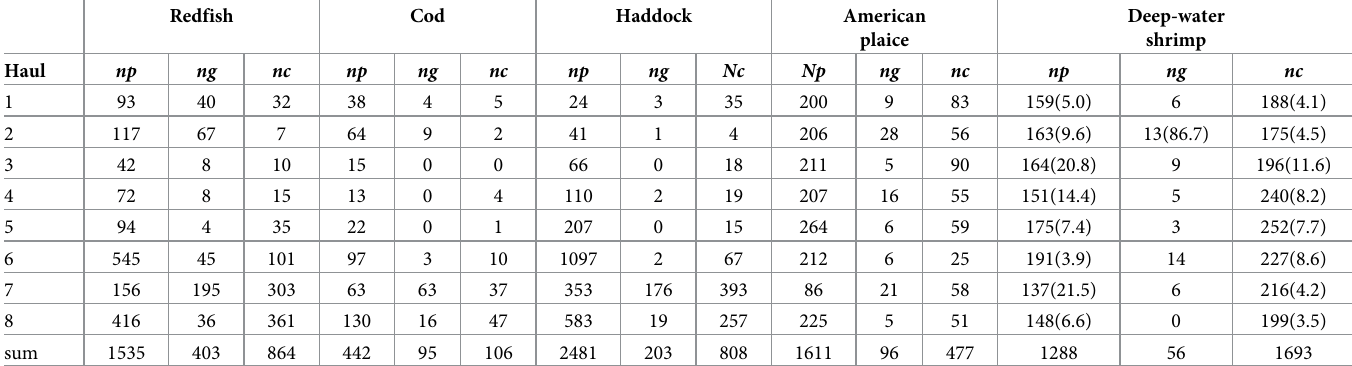
Table 1. Summary of the number of individuals length measured in catch data in each haul. np , ng , and nc denote the number of individuals measured from the sieve panel cover, the grid cover and the blinded codend, respectively. Values in parentheses are subsampling ratios in percentage (weight ratio), which are provided only if sub- sampling took